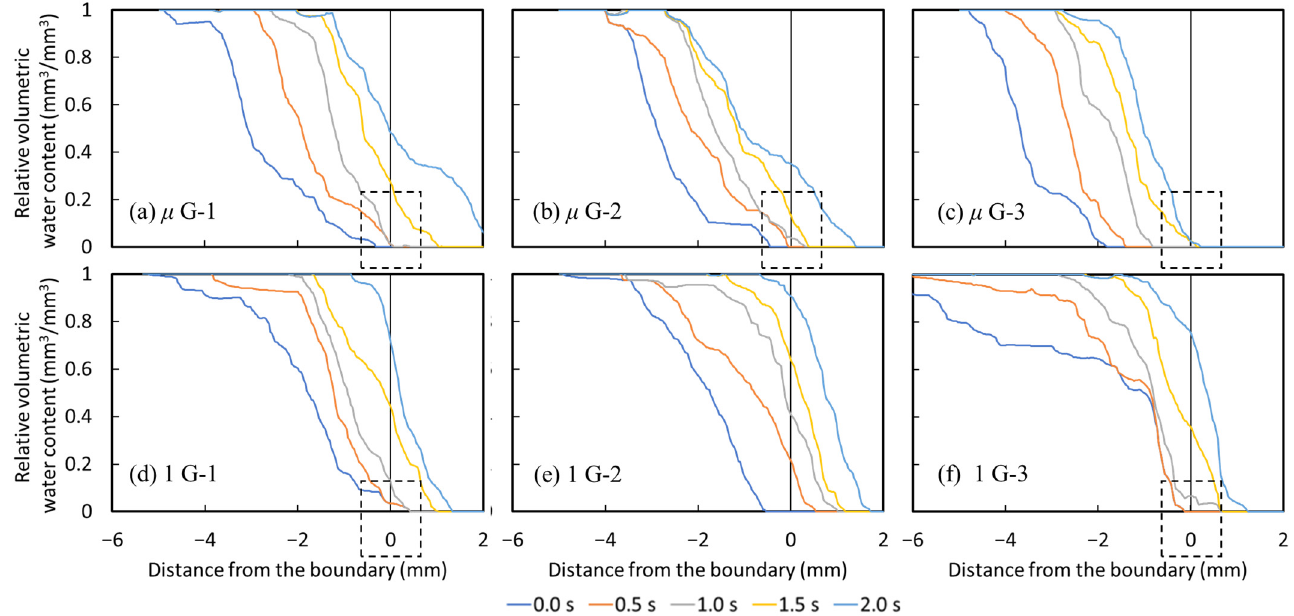
Figure 10. Relative volumetric water content observed under ( a – c ) microgravity and under ( d – f ) 1 G. The wetting front passed over the boundary both under microgravity and under 1 G.